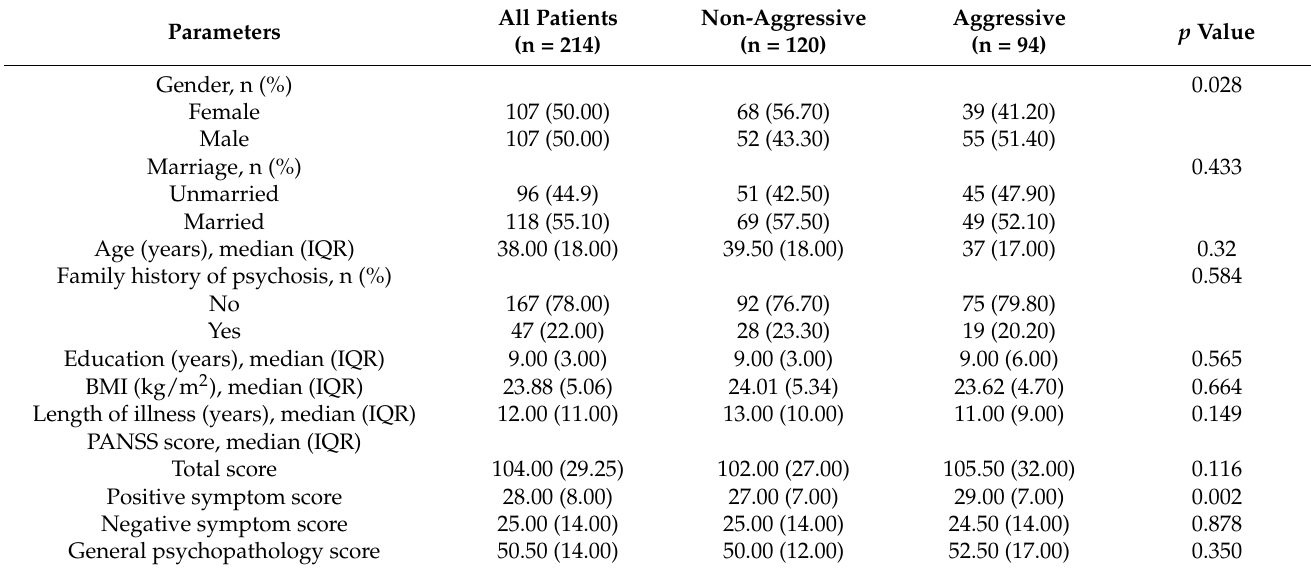
Table 1. Demographical and clinical characteristics of schizophrenia inpatients with aggression and without.